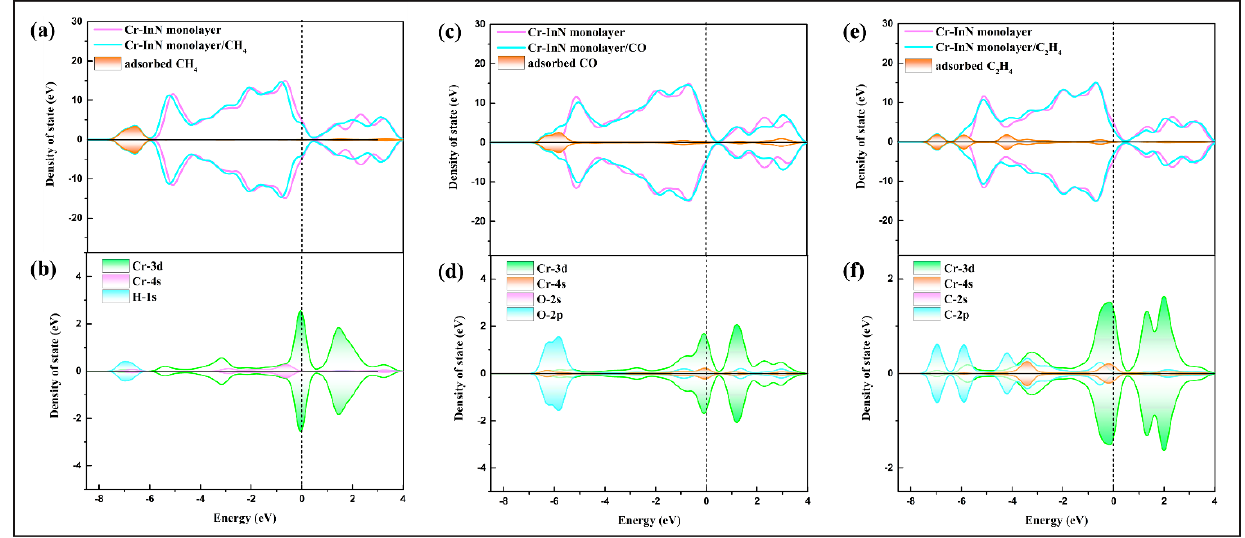
Figure 6. TDOS of ( a ) Cr-InN/CH 4 , ( c ) Cr-InN/CO, and ( e ) Cr-InN/C 2 H 4 ; PDOS of ( b ) Cr-InN/CH 4 , ( d ) Cr-InN/CO, and ( f ) Cr-InN/C 2 H 4 adsorption systems. First of all, for the CO and C 2 H 4 system (identical except for some new states brought about by the introduction of CO and C 2 H 4 molecules), the degree of overlap of the TDOS curve before and after adsorption was found to be quite high — the curve near the Fermi level, especially, was almost completely fitted. In PDOS, the O-2p orbital of the CO molecule and the Cr-3d and Cr-4s orbitals of the Cr atom overlapped around − 6 eV and between 1 and 4 eV; similarly, there was also overlap between the C-2p orbital of the C 2 H 2 molecule and the outer orbital of the Cr atom, manifesting the hybridization phenomenon between the O, C, and Cr atoms. In light of the aforementioned discussion of adsorption energy and electron density, it is believed that CO and C 2 H 4 molecules were firmly captured by the Cr–InN monolayer, which was also verified by PDOS analysis. However, the adsorption behaviors of CO and C 2 H 4 did not cause drastic changes in the electronic structure near the Fermi level of the Cr – InN monolayer. That is to say, although the Cr – InN monolayer can adsorb CO and C 2 H 4 molecules, it may not produce a remarkable response. As for the Cr – InN/CH 4 adsorption system, we first paid attention to its PDOS distri- bution. Similarly to the conclusions obtained from the adsorption energy and charge- transfer analysis, we found that the H-1s atomic orbital in the CH 4 molecule had a slight overlap with the Cr-4s orbital in the range from − 8 to − 6eV, which again suggests that the CH 4 molecule was present in the Cr – InN monolayer. The chemical bond that was formed was relatively weak. However, the change in TDOS distribution shows that the electronic distribution of the Cr – InN monolayer was remarkably changed by the adsorption of CH 4 molecules. Figure 6a directly shows that the overall state in the adsorption system was low. The energy direction moved, and its energy band seemed to significantly change, that is, the conductivity of Cr – InN may have been reduced due to the adsorption of CH 4 . 3.5. Band Structure Analysis It is widely believed that there is a classic relation between band gap and electrical conductivity [31,32], that is, at a certain temperature, the conductivity is inversely propor- tional to the band gap. Here, band structure was used to qualitatively analyze the influ- ence of gas adsorption on the band gap of the Cr-doped InN monolayer. We can further explore the response of the intrinsic Cr – InN monolayer to the adsorp- tion behavior of the three gases through the band structure of the Cr – InN monolayer sys- tem shown in Figure 7. Before adsorption, the band gap of the Cr – InN monolayer was 0.683 eV, and after the adsorption of CH 4 , CO, and C 2 H 4 gas, it dropped to 0.560, 0.598,